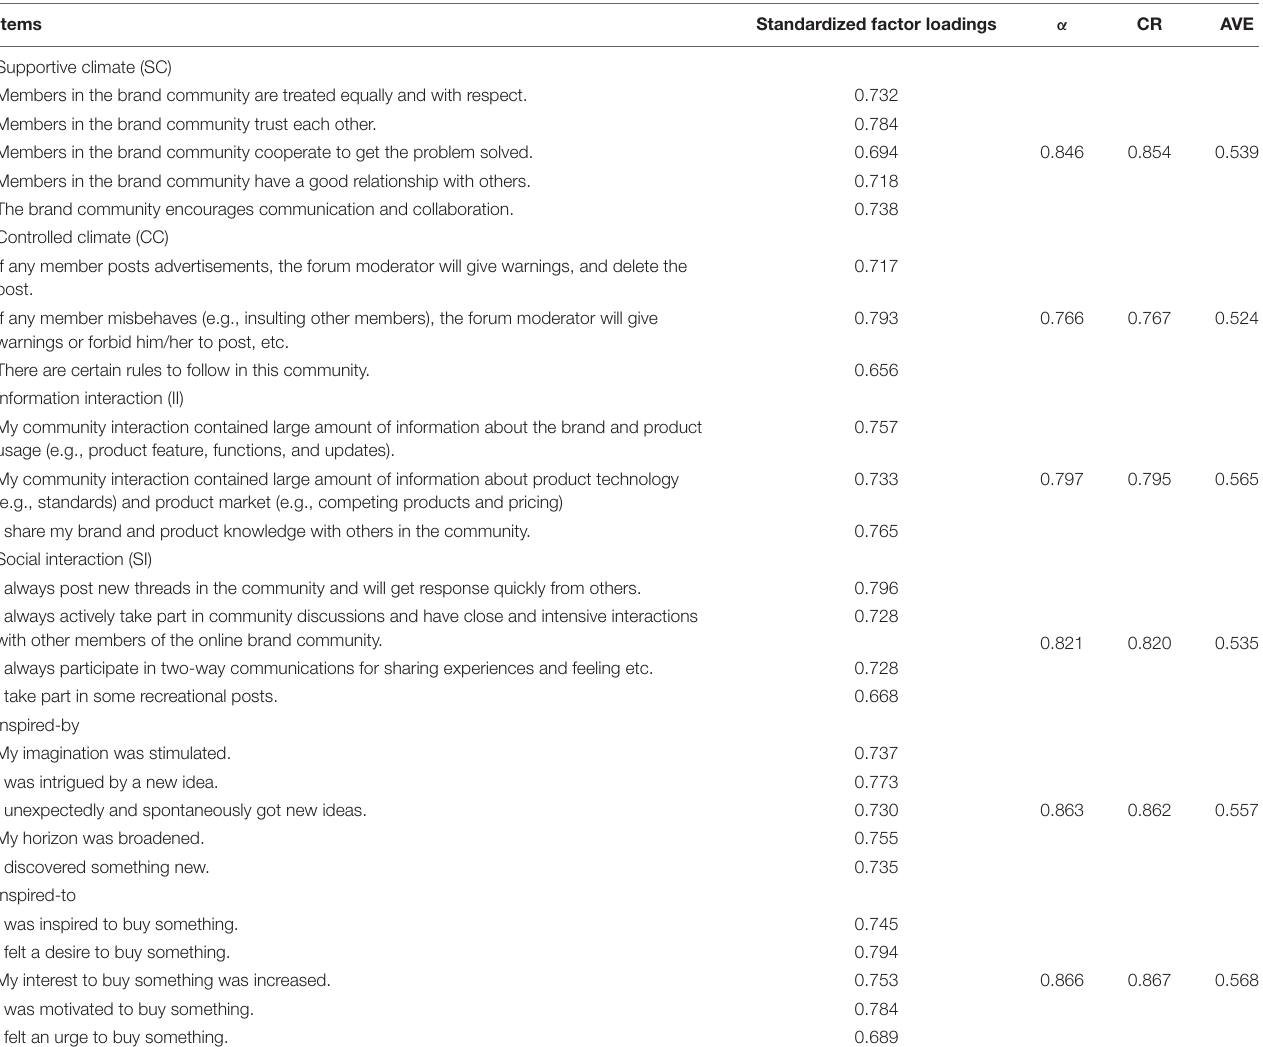
TABLE 2 | Measure items, the reliability, and convergent